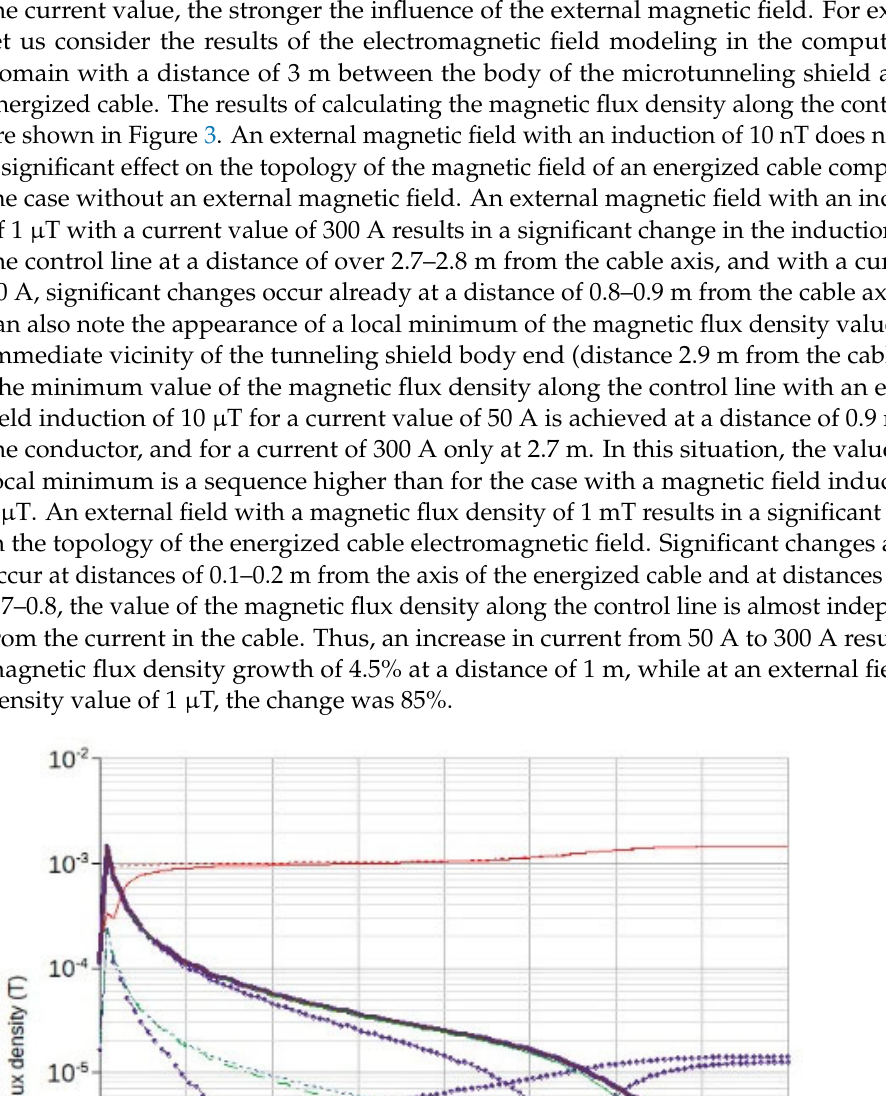
Figure 3. Values of magnetic flux density along the control line at a distance of 3 m between the microtunneling shield and the cable.